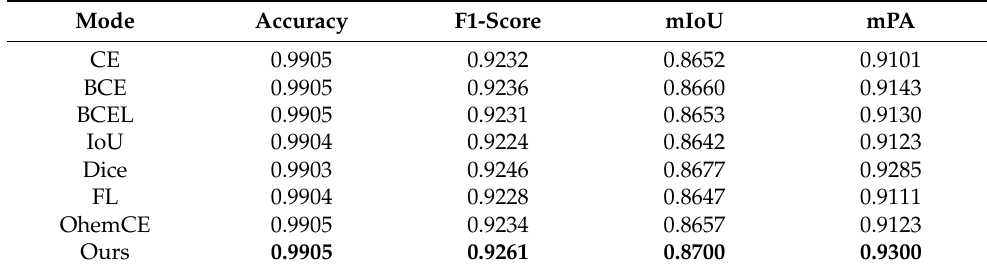
Table 7. Results of different loss functions.